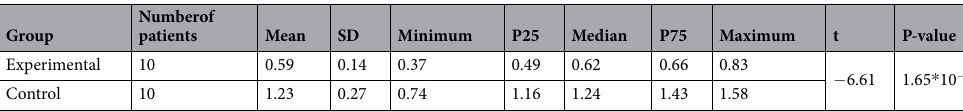
Table 2. Comparison of AD of landmarks(mm). Using the independent-sample t-test for comparisons; the statistical magnitude was